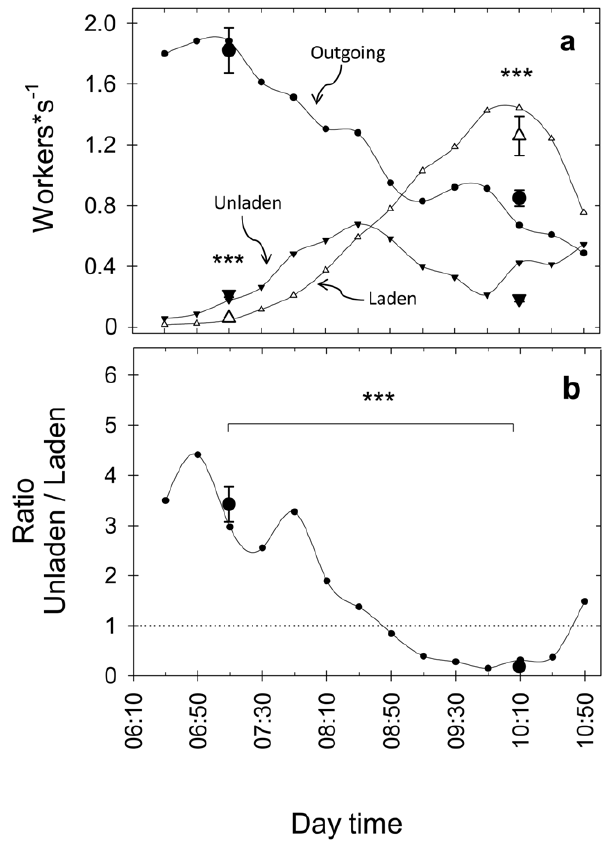
Figure 1. Traffic flows of outgoing, returning laden and unladen workers in field colonies. A ) Lines : average traffic flow recorded every 20 minutes in a single colony during six consecutive days. Large symbols : average number of workers (mean 6 SD) from single measurements on 12 colonies at both the initial (07:10h) and established (10:10h) foraging phases. B ) Ratio between unladen and laden returning workers. Line : average ratio obtained from the counts every 20 minutes in a single colony, during six consecutive days. Large black circles : average ratio from single measurements on 12 colonies at both the initial (07:10h) and established (10:10h) foraging phases. Asterisks indicate a statistical difference at p , 0.001.